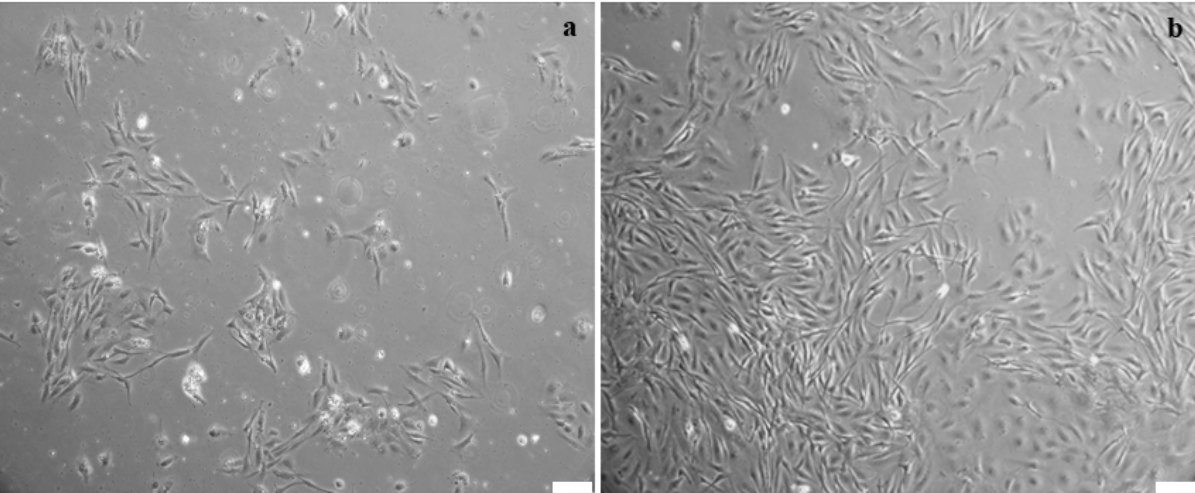
Figure 1 ‒ Primary cell culture following the enzymatic digestion of the fin tissue of Hollandichthys multifasciatus and the cell confluence after four days (a) . Cell population in the second cultivation ( b ). Scale bar = 100 µm.